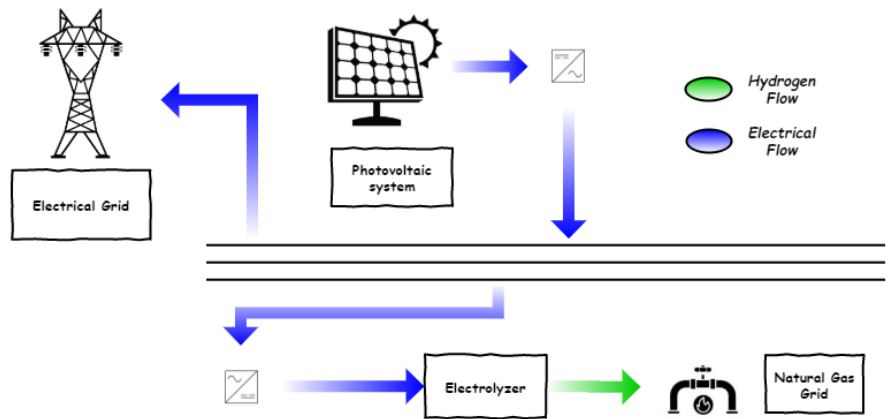
Figure 3. Schematic of the HES where interface with natural gas grid is considered.